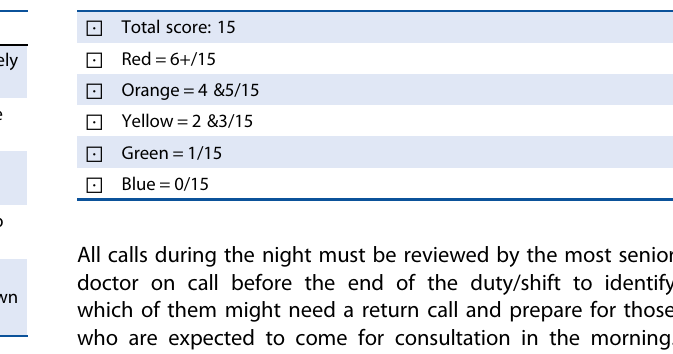
Table 3: Telephone triage score 15